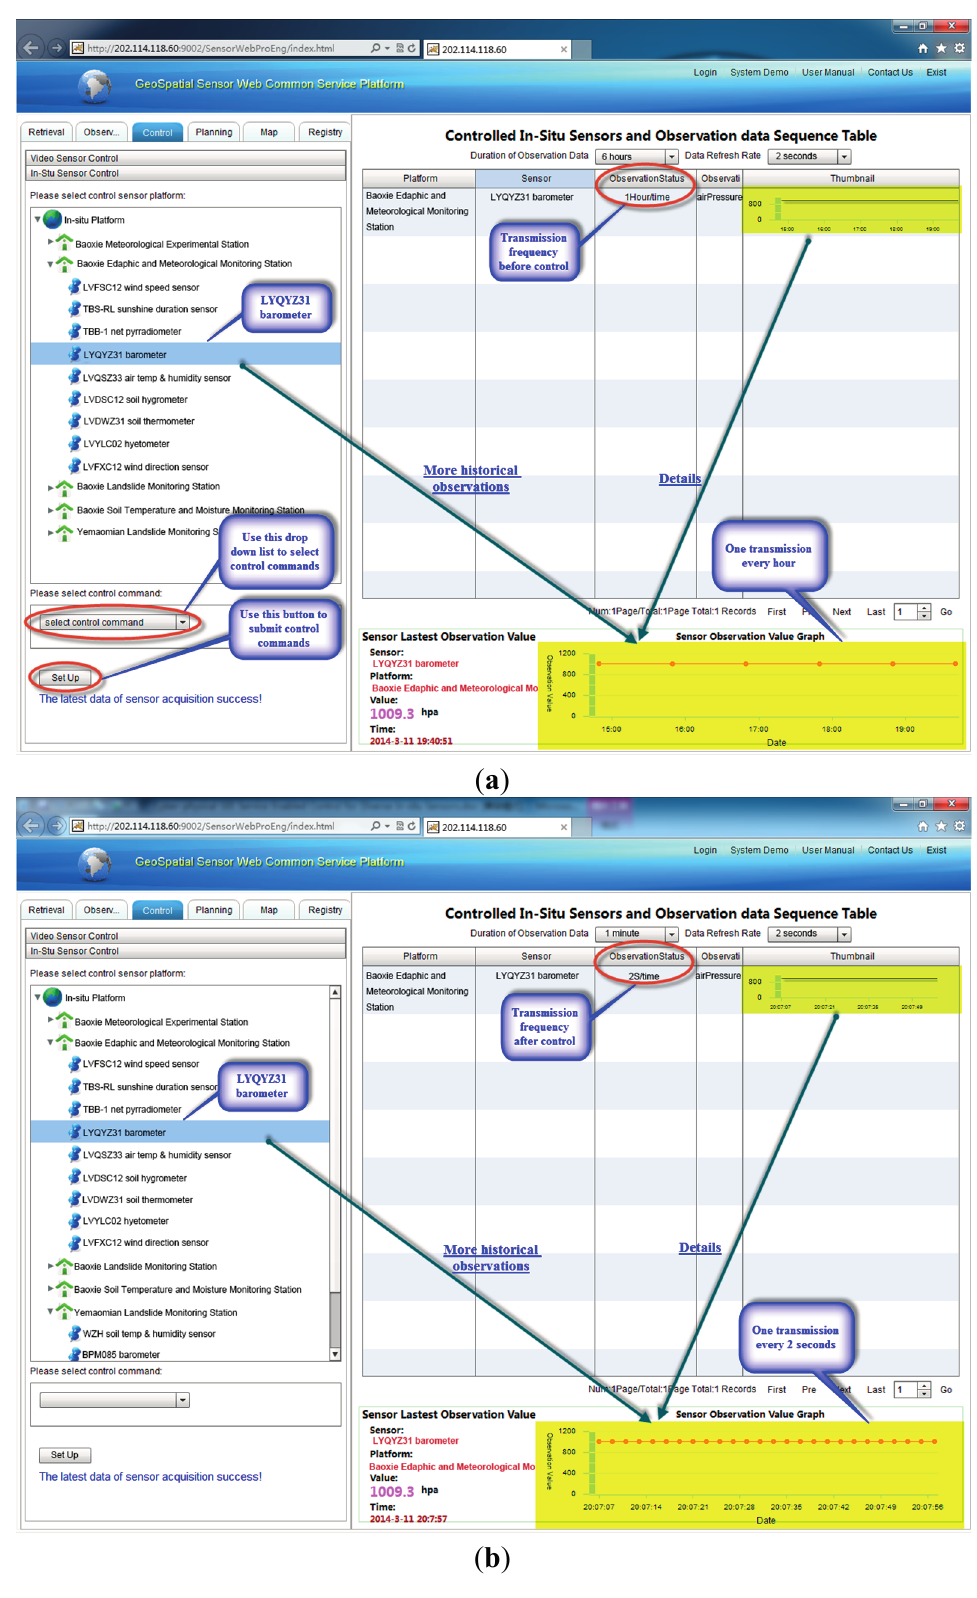
Figure 9. ( a ) Chart view of observations of the LYQYZ31 barometer before the frequency change; ( b ) Chart view of observations of the LYQYZ31 barometer after the frequency